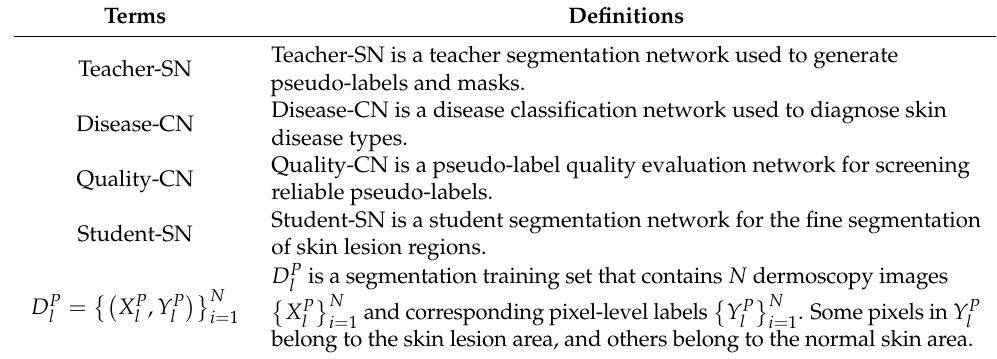
Table 1. Terms and corresponding